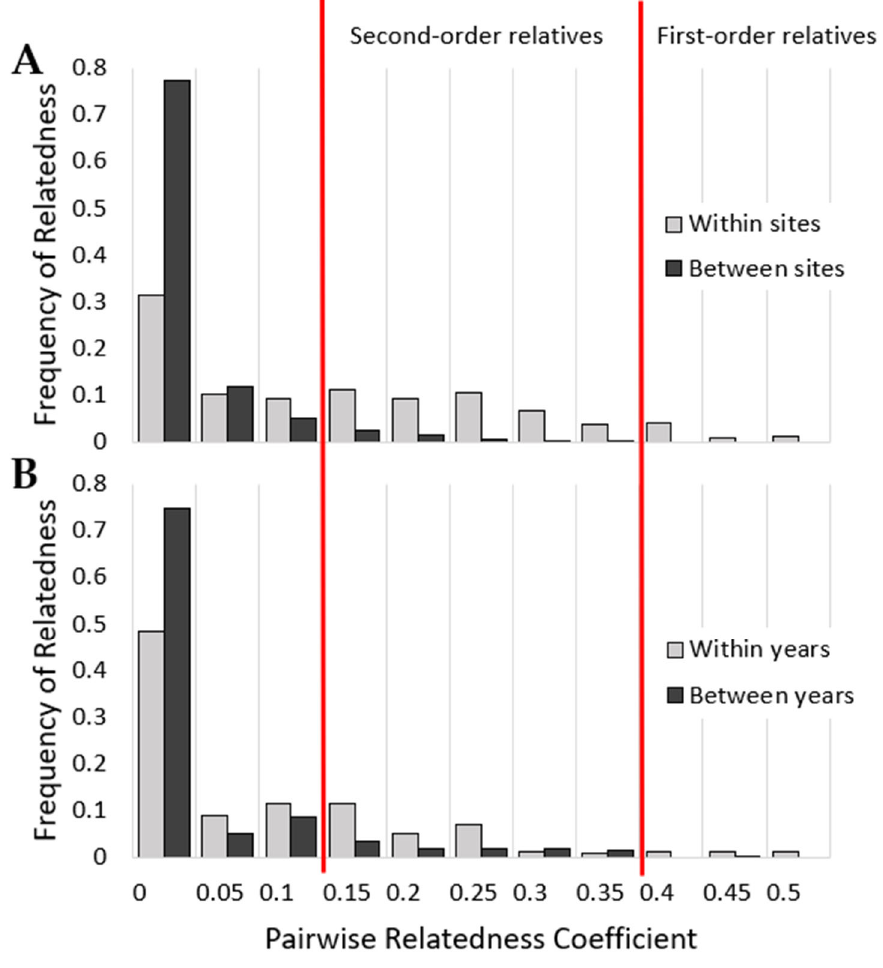
Figure 3. ( A ) Histogram of pairwise relatedness coefficients (Lynch–Ritland estimator) of coyotes within sites and between sites. ( B ) Histogram of pairwise relatedness coefficients (Lynch–Ritland estimator) of coyotes within sampling years and between sampling years in the BFS. In both plots, negative values were converted to zero. Red bars mark r = 0.1 and r = 0.4. Values between 0.1 and 0.4 indicate second ‐ order relatives, and values greater than 0.4 indicate first ‐ order relatives.